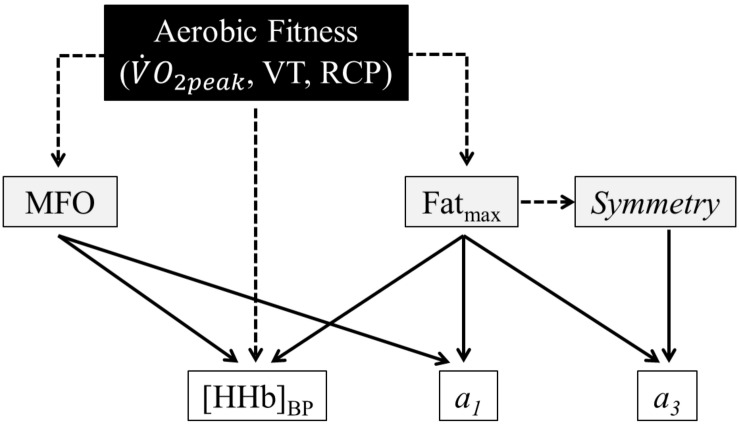
Schematic representation of the correlations among aerobic fitness [peak oxygen uptake (V.O2⁢p⁢e⁢a⁢k), ventilatory threshold (VT), and respiratory compensation point (RCP)], whole-body fat oxidation kinetics [maximal fat oxidation (MFO) and exercise intensity at which MFO occurs (Fatmax) and the symmetry variable], and muscle deoxygenation kinetics [the slopes of the first (a1) and second (a3) parts of the curve of the double linear model].